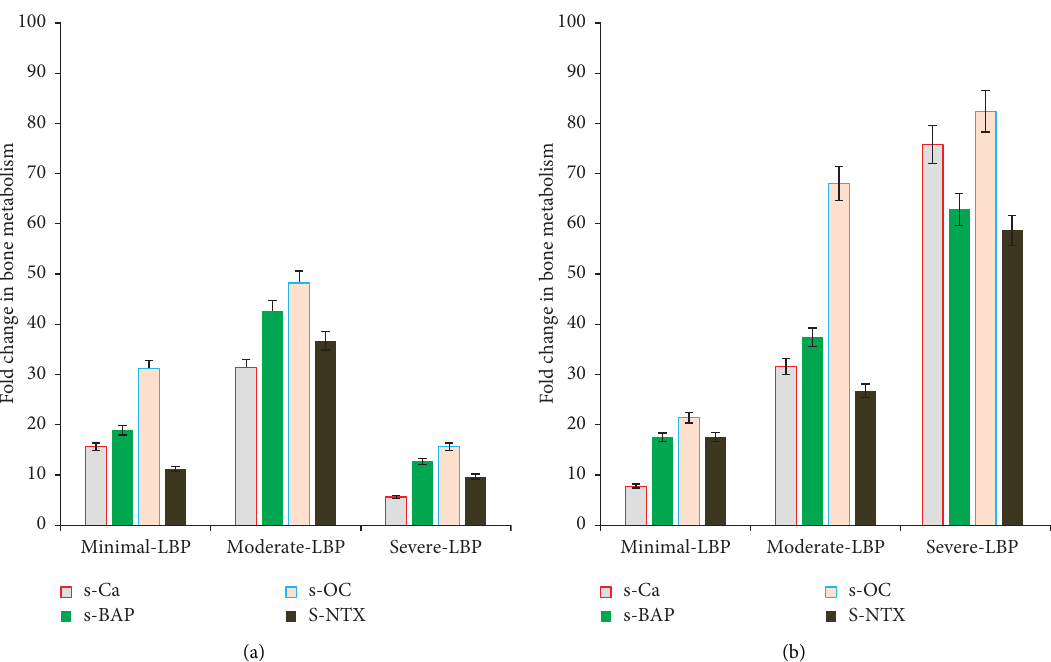
Figure 3: Effect of gender on the biosynthesis of serum bone metabolism markers as s-CA, s-BAP, s-OC, and s-NTX in all subjects with different LBP scores. Fold change in all estimated bone markers showed that s-CA, s-BAP, s-OC, and s-NTX are significantly ( p � 0 . 001) reduced in female subjects with minimal, moderate, and severe LBP scores compared to male subjects of the same